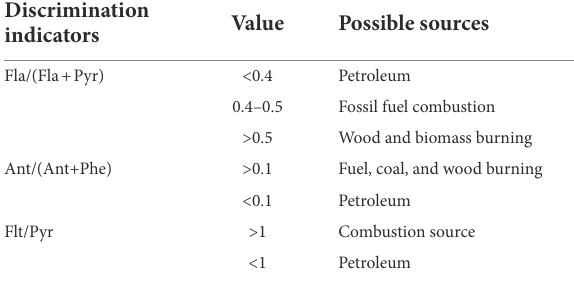
TABLE 2 Source discrimination indicators of PAHs in Jiadengyu peatlands in the Altay